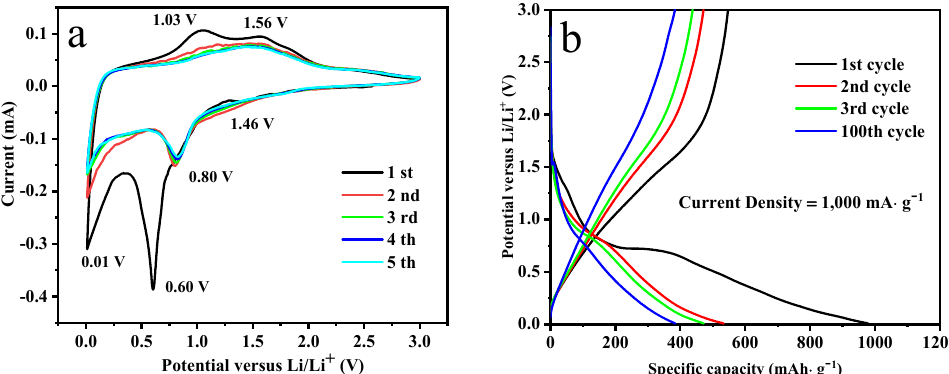
Figure 4. The CV curves for the initial five cycles ( a ), charge and discharge voltage profile ( b ) of the Fe 3 O 4 @C composite.